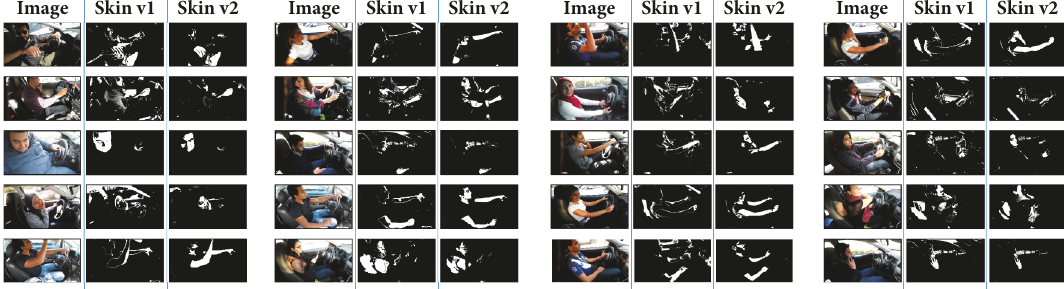
Figure 5: Our skin segmentation algorithm (v1 & v2) is run against sample test images. “Skin v2” is trained on pixel spatial information, while “Skin v1” is only trained on pixel color